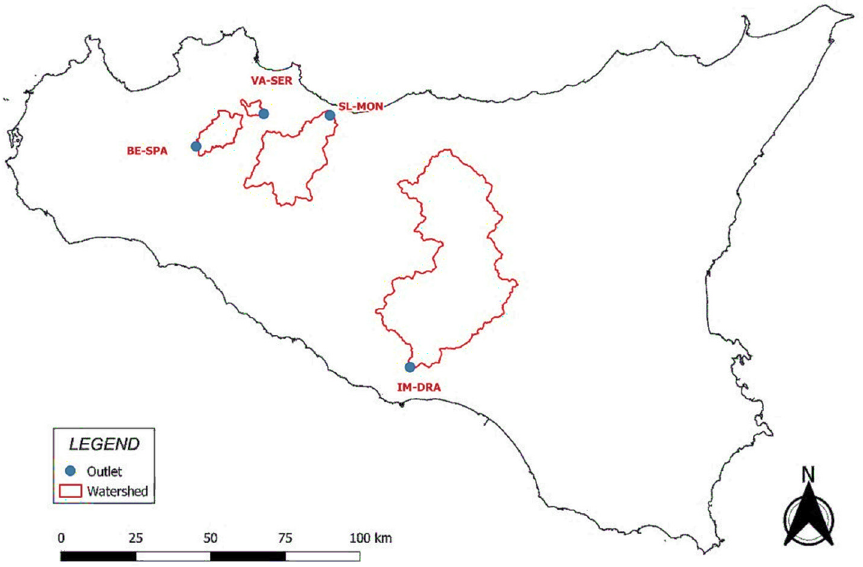
Figure 2. Locations of the gauges considered in this study and the related catchments overlaid on the perimeter of Sicily.